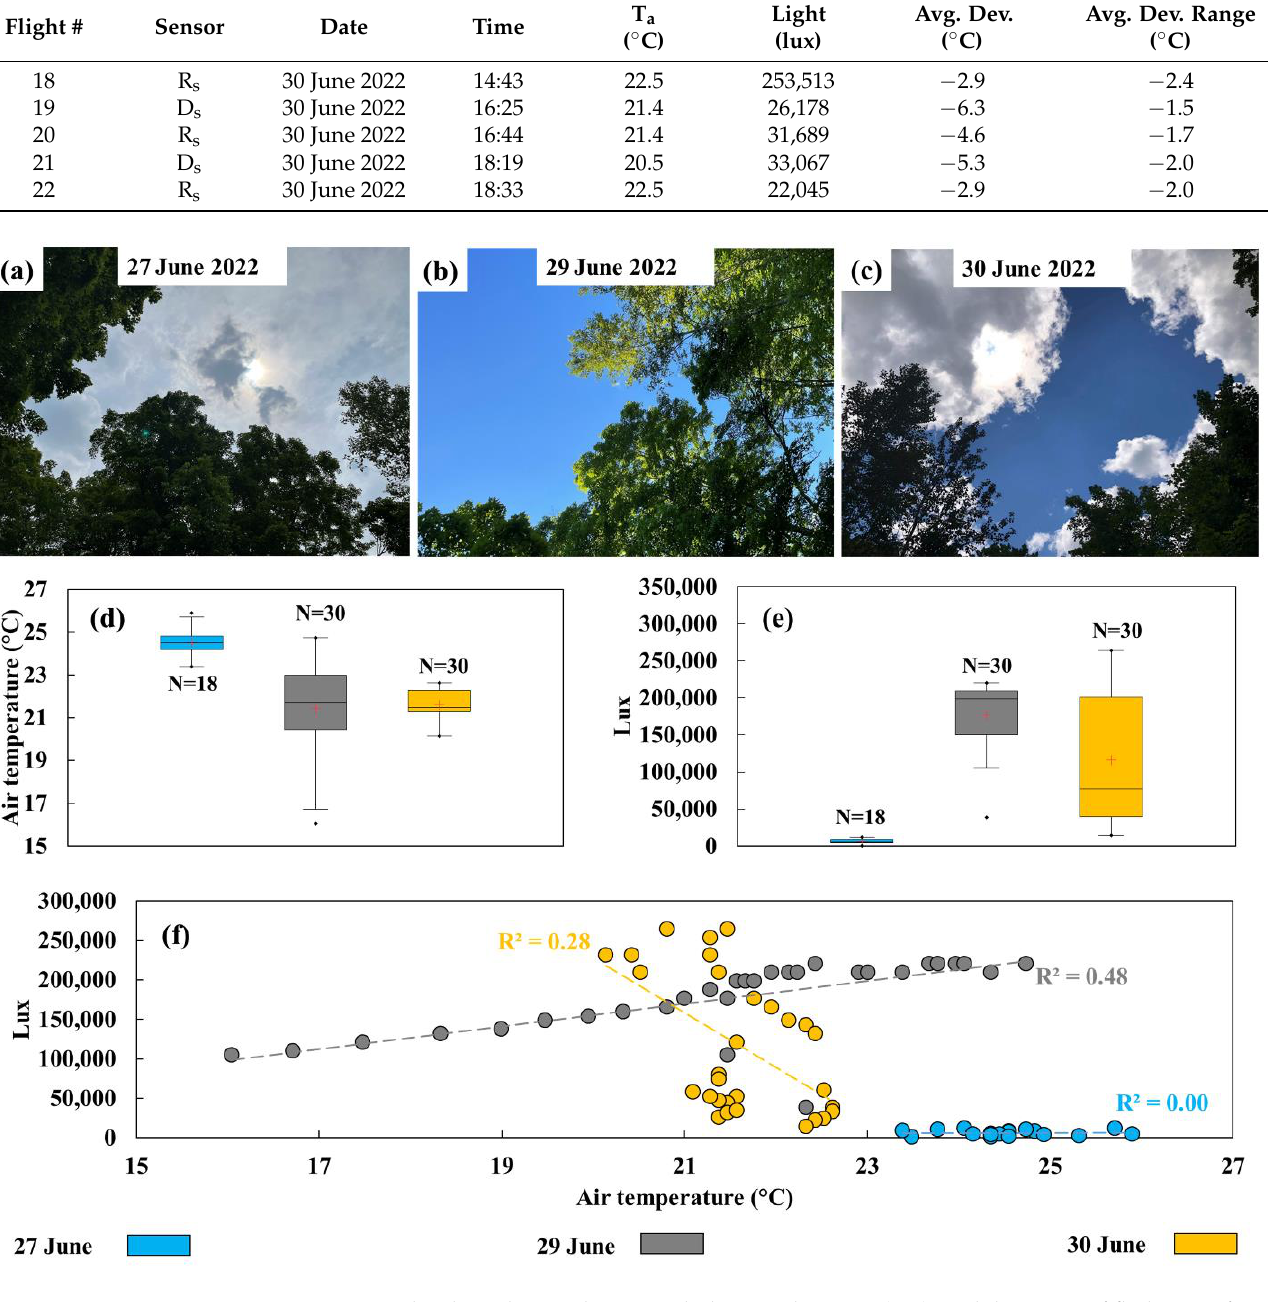
Figure 5. Cloud conditions during each day are shown in ( a – c ), and the range of flight specific air temperature and light intensity conditions (measured by lux) for each day are illustrated in ( d , e ), respectively. The relationship between light intensity and air temperature for each flight reveals no correlation on 7 June, a positive correlation on 29 June, and a negative correlation on 30 June, where the date of data acquisition is denoted by the different colour points ( f ). Table 2. The air temperature (T a ) and light intensity conditions (lux) are provided for each flight, in concert with sensor specific average deviations (Avg. dev. °C) and average deviation ranges (Avg. dev. range °C). The Avg. dev. (sensory accuracy metric) was calculated as the radiant temperature (T R ) minus the kinetic temperature (T K ) for each flight averaged across the n = 12 instream loggers. The Avg. dev. range is simply the range of Avg. dev. for each flight calculated by T R minus T K and represents sensor precision. # is the flight number.